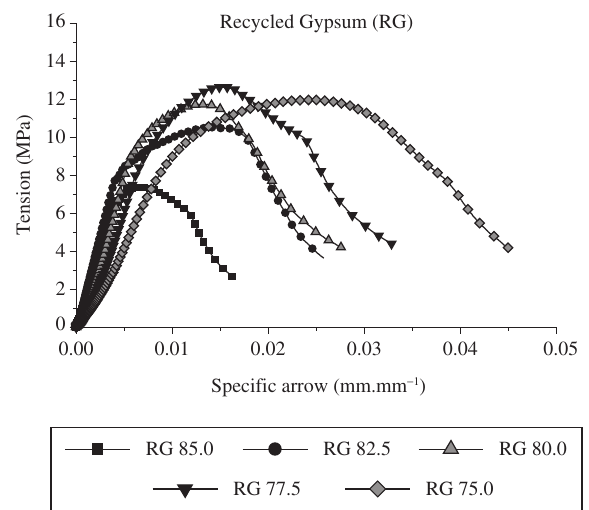
Figure 9. SEM and secondary electron images. Matrix without